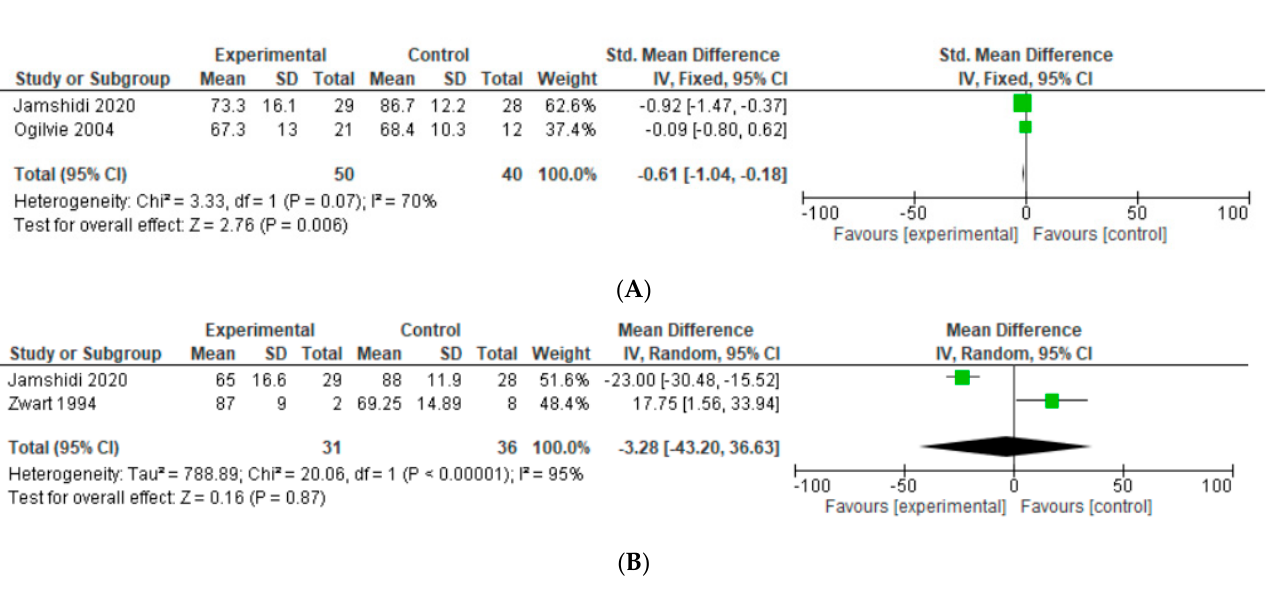
Figure 5. ( A ) Forest plot of MSTS comparing in proximal femur tumor patients undergoing HA and THA. ( B ) Forest plot of HHS comparing in proximal femur tumor patients undergoing HA and